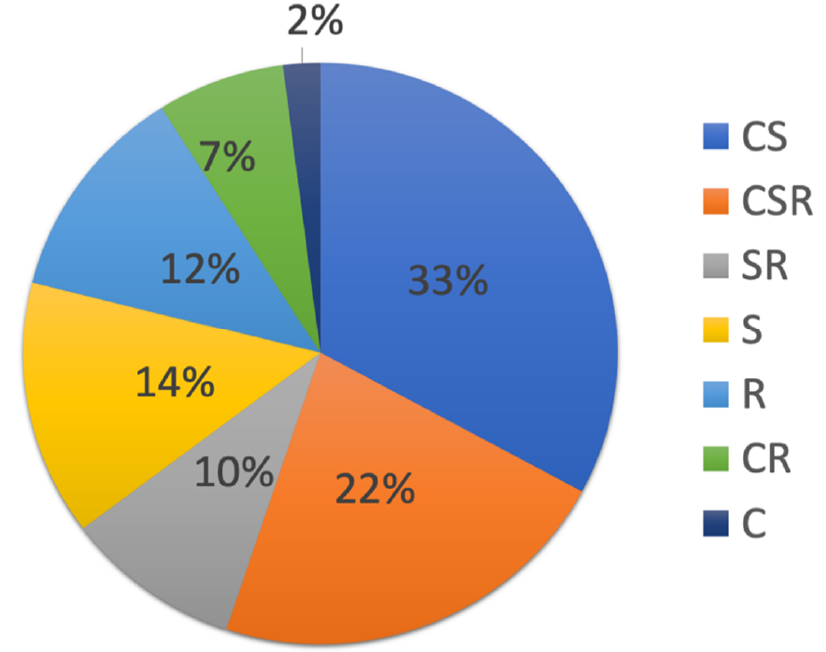
Figure 5. Average percentage of each Grime strategy in the studied mosaic of habitats at the former mine site. CS: competitive, stress tolerant; CSR: competitive, stress tolerant, ruderal; SR: stress tolerant, ruderal; S: stress tolerant; R: ruderal; CR: competitive ruderal; C: competitive.